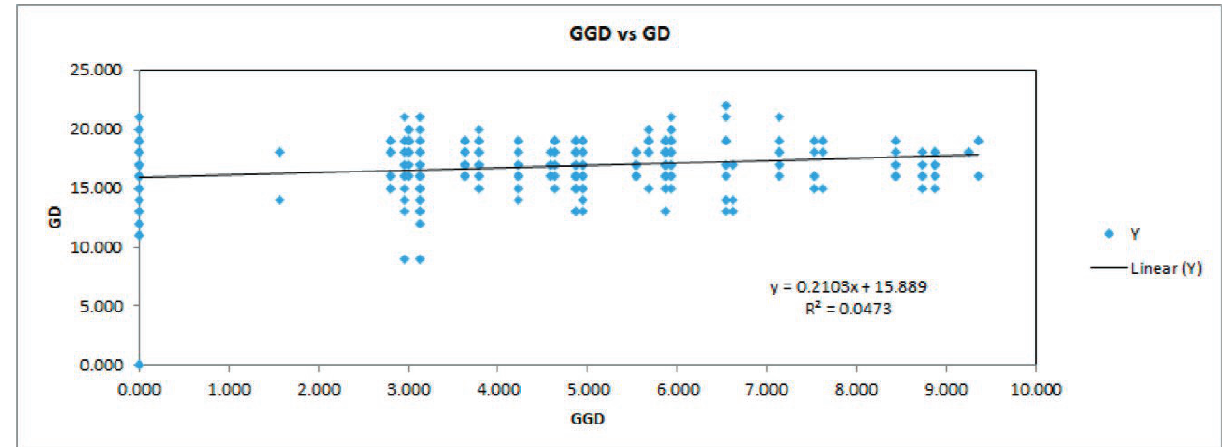
Figure 4. Mantel test between genetic and geographic distance of rice genotypes showing positive significant association. (Populations 1-10 are: 1) Mazandaran, 2) Gilan, 3) Unknown, 4)Golestan, 5) Isfahan, 6) Khuzestan, 7) Fars, 8) Philipine, 9) Boushehr, 10)